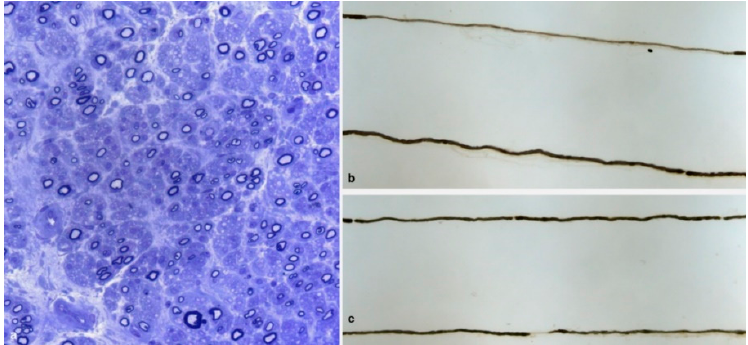
Figure 2. Sural nerve biopsies from a 71 ‐ year ‐ old Tyr78Phe ( a ) and from a 68 ‐ year ‐ old Phe64Leu ( b ) hATTR patients. Semithin sections stained with toluidine blue. An inhomogeneous interfascicular fiber loss is evident ( a ): in two fascicles only isolated myelin fibers were present while other fascicles show an asymmetrical fiber loss. An inhomogeneous intrafascicular fiber loss is present ( b ).